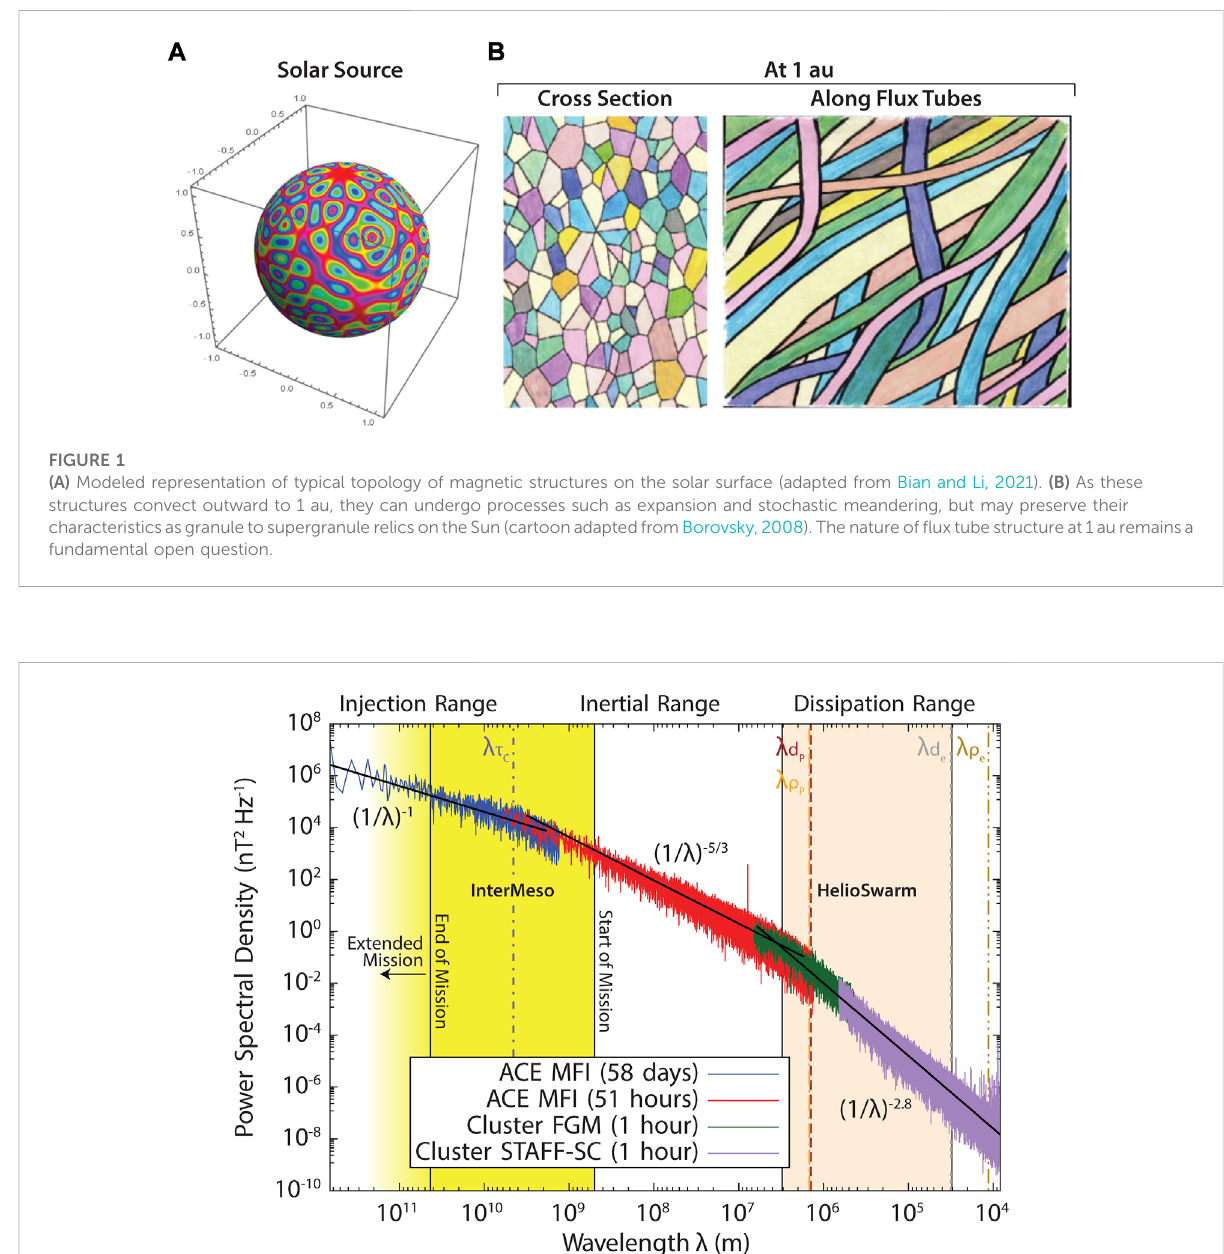
Ashraf and Li, 2019; Bian and Li, 2021). As such, once fl ux tubes reach 1 au, they can be tangled into a complex meso-structure (illustrated in Figure 1B) (Borovsky, 2008). These processes and structuring can lead to various effects, such as “ dropout ”